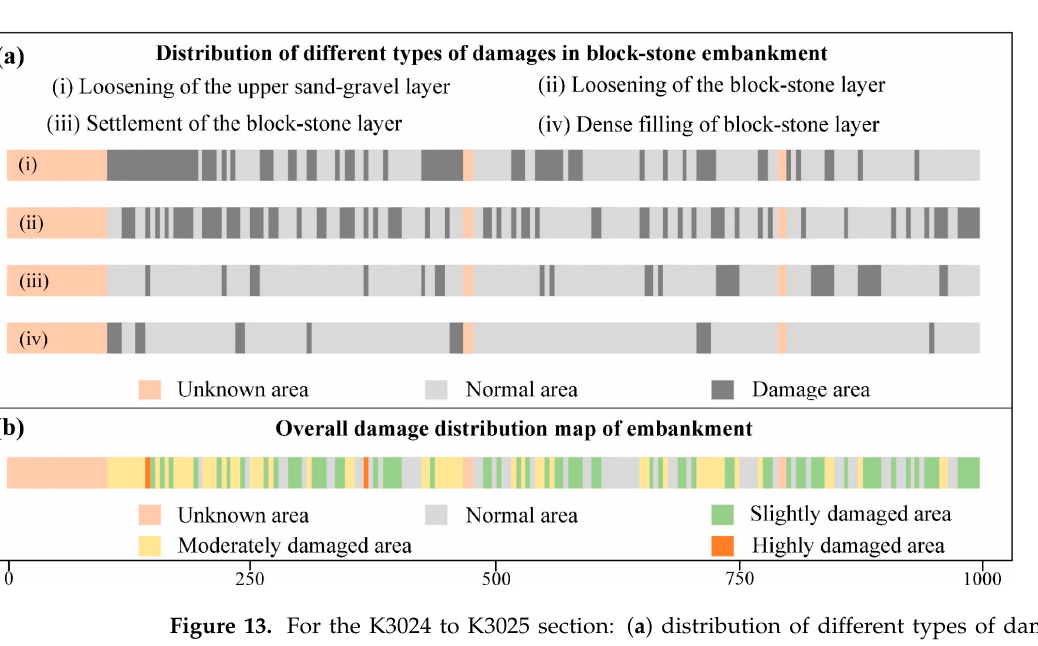
Figure 12. Comparison of the results of different processing methods for abnormally dense areas: ( a ) processed according to the normal flow; ( b ) after direct wave removal only gain processing was performed; ( c ) only horizontal signals were removed based on the previous step; ( d ) only moving-average processing was performed based on the previous step. The yellow arrow is used to increase visibility.